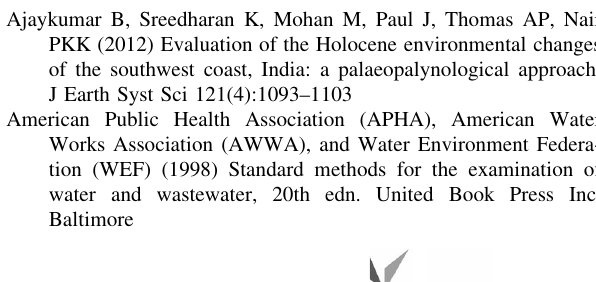
Fig. 8 HCA dendrogram for a PRM, b MON and c